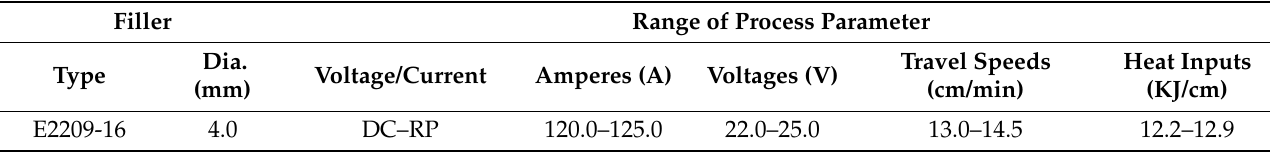
Table 2. Welding parameter for welding